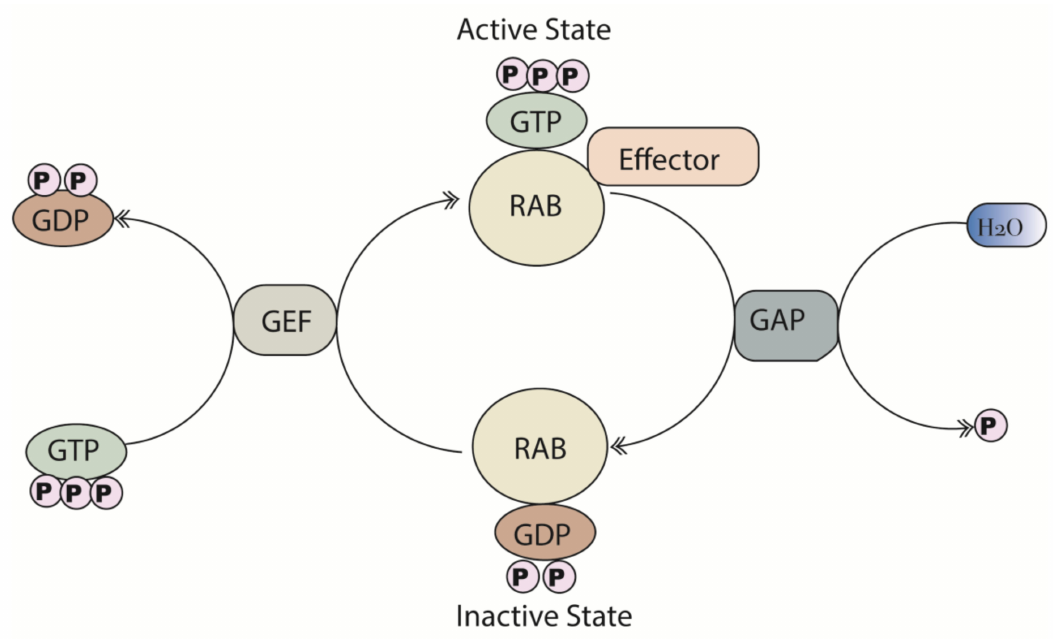
Figure 2. Schematic representation of the Rab GTPase cycle. Rab proteins oscillate between an active guanosine triphosphate (GTP)-bound state and an inactive guanosine diphosphate (GDP)-bound state. The activation and inactivation is regulated by guanine nucleotide exchange factors (GEFs) and GTPase-activating proteins (GAPs), respectively. Rab proteins, in the active (GTP-bound) state promote downstream signaling through the interaction of e ff ector